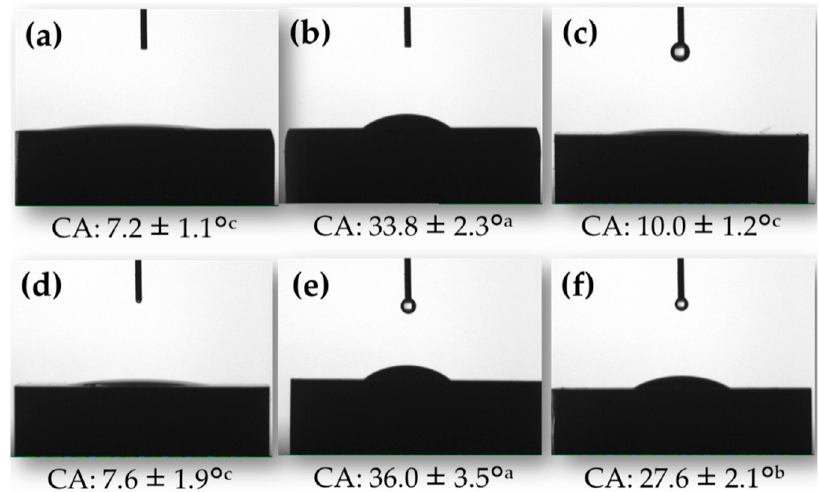
Figure 2. Representative cross-sectional images of a water droplet on glass ceramic surfaces: ( a ) control (only K-etchant); ( b ) SEP/PBA; ( c ) APP; ( d ) UV; ( e ) APP + SEP/PBA; and ( f ) UV + SEP/PBA. CA: contact angle (mean ± SD, °). Values with the same superscript letters showed no statistical significance ( p > 0.05). Table 2. Microtensile bond strength (µTBS) and number of pre-testing failure (PTF) in each group. µTBS Group Treatment Median (Range) PTF/ n (Mean ± SD; MPa) Control (K-etchant)